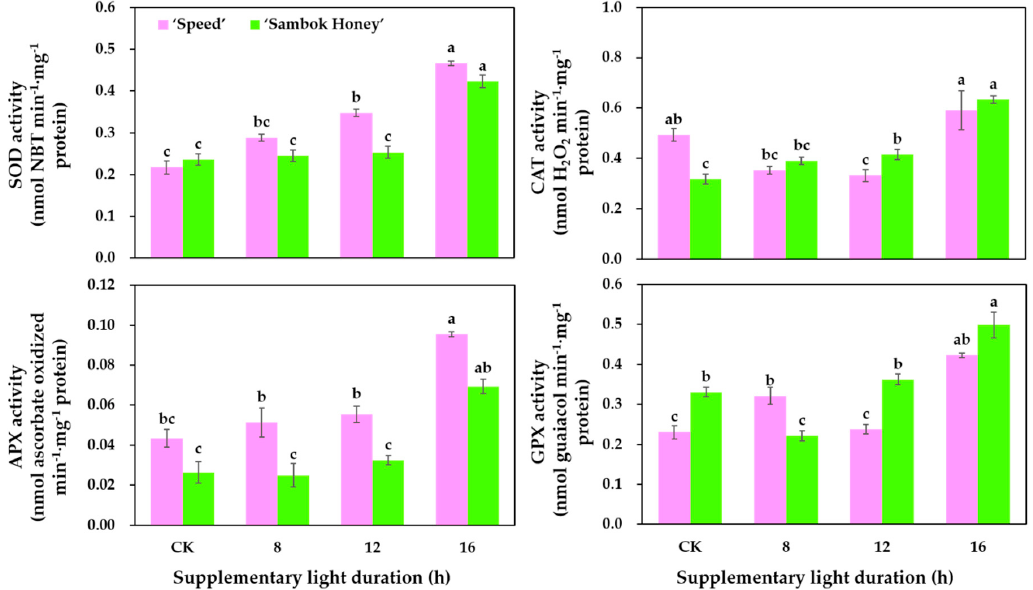
Figure 7. The effects of the supplementary light duration on the activities of four antioxidant enzymes (superoxide dismutase, SOD; catalase, CAT; ascorbate peroxidase, APX and guaiacol peroxidase, GPX) in seedlings of two cultivars of watermelon, ‘Speed’ and ‘Sambok Honey’, grafted onto ‘RS Dongjanggun’ bottle gourd rootstocks, after 10 days of supplementary light treatments. The error bars represent the SEs of the biological replicates ( n = 3). The mean separation within columns are significantly different according to Tukey’s multiple range test at p = 0.05.